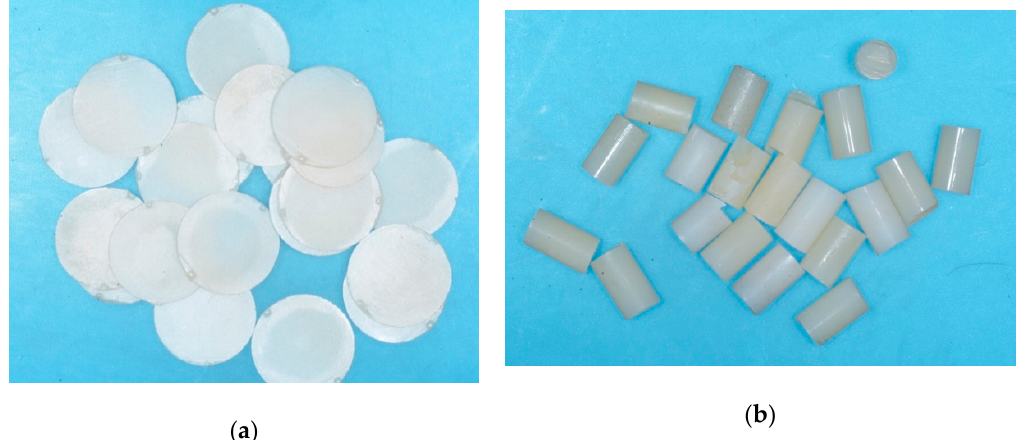
Figure 1. ( a ) Y-TZP disks used for the study (10 mm diameter, 0.5 mm thick) (n = 20); ( b ) Nano-hybrid composite cylinders created for the study (4 mm diameter, 8 mm height) (n = 20). Table 3. List of materials used for the experimental phase of study.